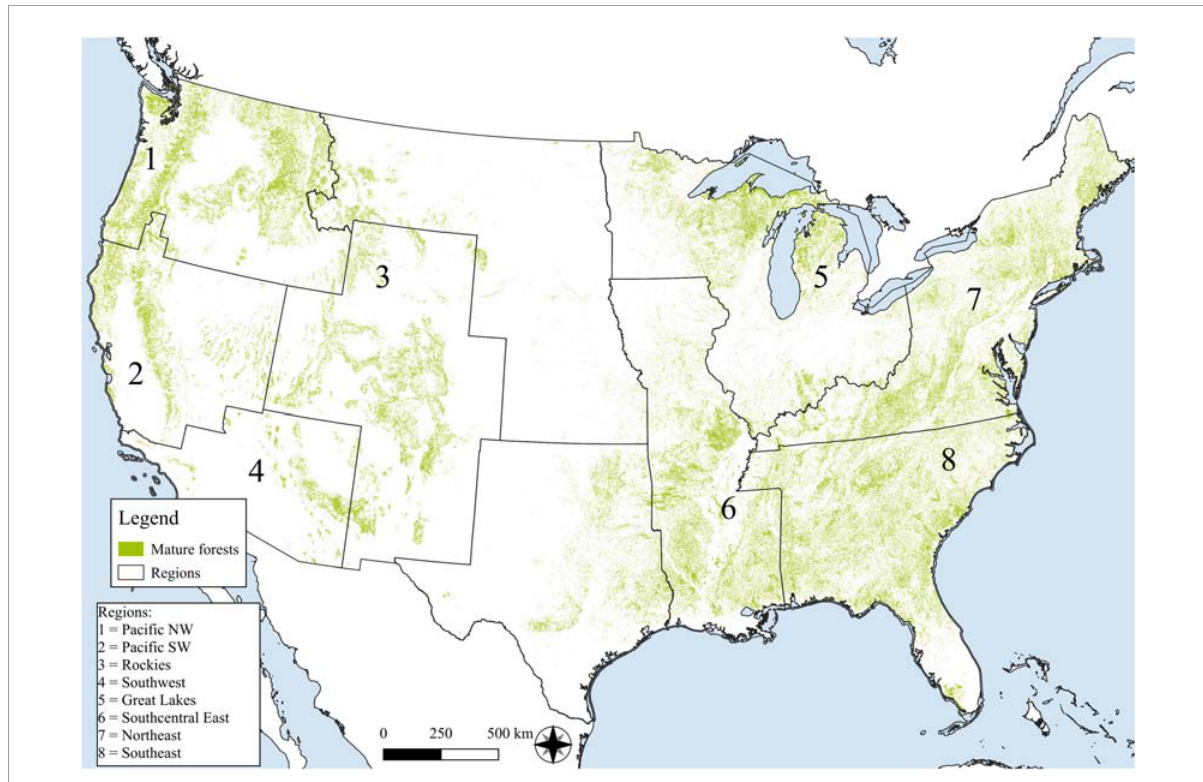
FIGURE2 Distribution of modeled mature and old-growth forests (MOG) for the conterminous United States. Forest regions with MOG are